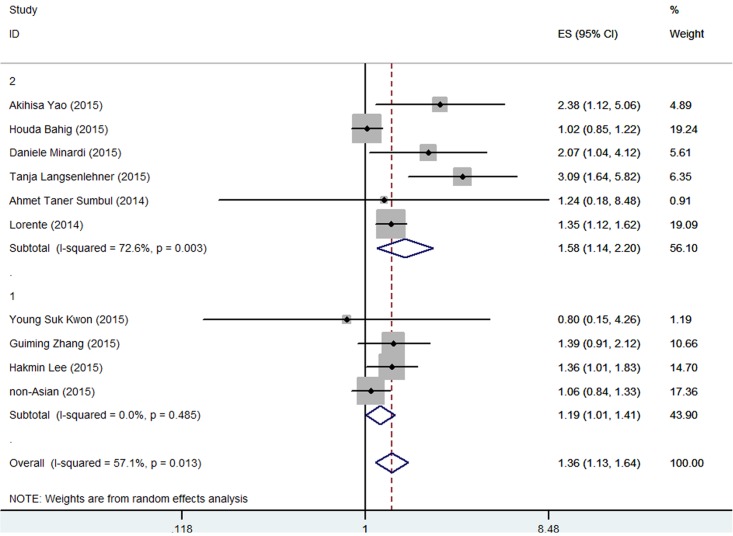
Meta-analysis of NLR value and RFS in PCa patients.